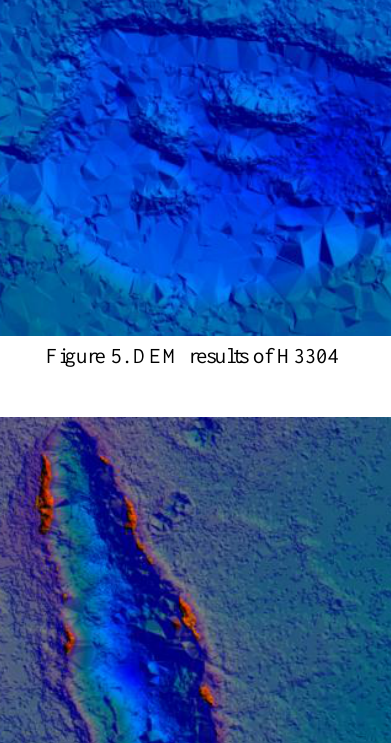
Table 1. Errors between prediction points and real points